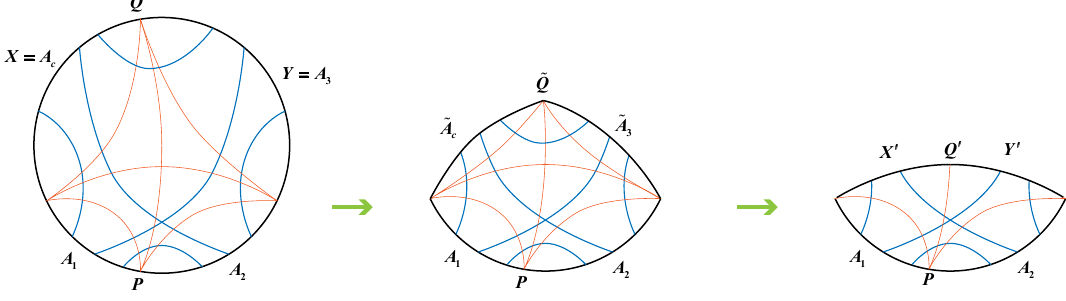
Figure 4 . Imagine we gradually move the dividing point Q of XY (or A c A 3 ) to the dividing point Q 0 of X 0 Y 0 (or A 0 A 0 ) along the geodesic PQ and accordingly push XY into the bulk until it reaches c 3 X 0 Y 0 , while keeping the locking behavior of the thread configuration all the